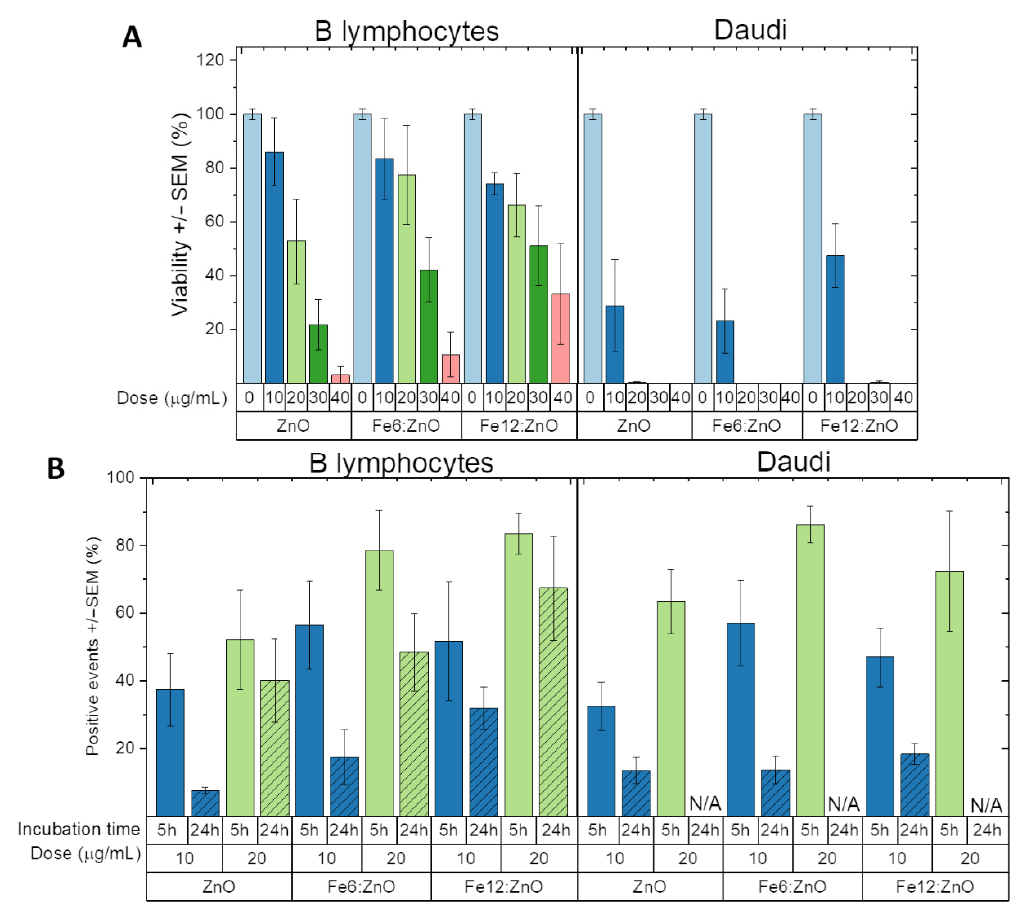
Figure 11. ( A ) B lymphocyte and Daudi cell viability evaluated through the WST-1 assay at 24 h after ZnO and Fe:ZnO NPs administration. ( B ) B lymphocyte and Daudi cell Fe:ZnO NP uptake evaluated through cytofluorimetry at 5 and 24 h after NP administration to cells. N/A denotes experiments for which the high NP toxicity resulted in the number of events presenting insufficient values for the evaluation of the NP uptake. Error bars express standard error mean.